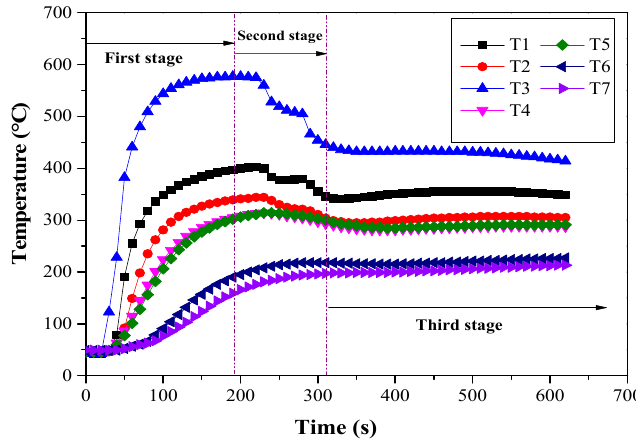
Figure 2. The temperature variation over time after ignition, v = 0.3 m/s and Φ = 1.0.